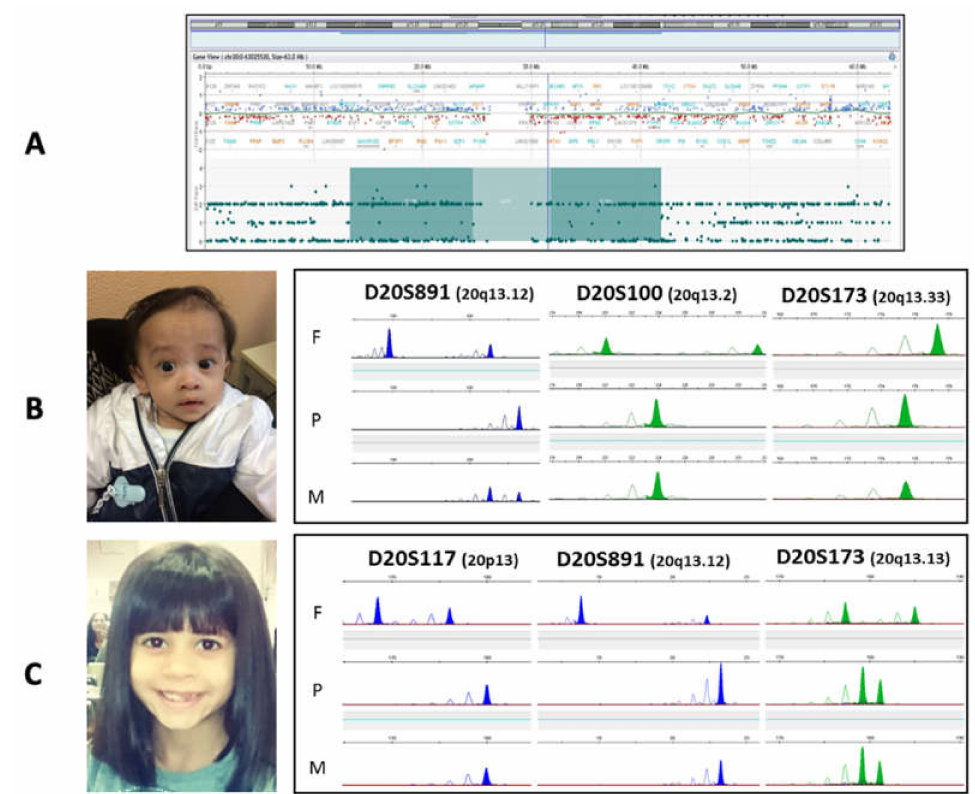
Figure 3. Panel ( A ): CGH+SNP array results of patient 1: the snapshot shows a balanced profile of the entire chromosome 20 and a 21Mb pericentromeric region of absence of heterozygosity. The AOH region encompasses 343 homozygous SNP polymorphisms. Of these, a total of 286 SNPs was informative on both the proband and the parents showed evidence of maternal isodisomy (dark green areas of the rectangle). Panels ( B , C ) show pictures of the patients with UPD(20) (on the left) and the STR analyses (on the right) of probands 2 and 3, respectively. The photos show patient 2 at the age of 5 months and patient 3 at the age of 8. Clinical features become more subtle after the first year of life. First infancy photos are not